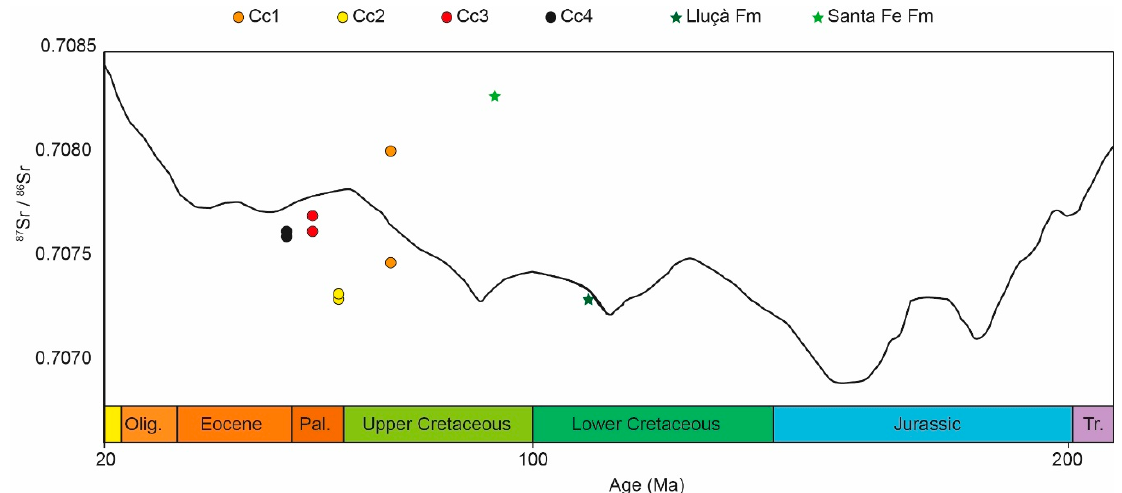
Figure 13. 87 Sr/ 86 Sr composition of calcite cements and carbonate host rocks. The 87 Sr/ 86 Sr variation of seawater through time is represented with the black line [93].